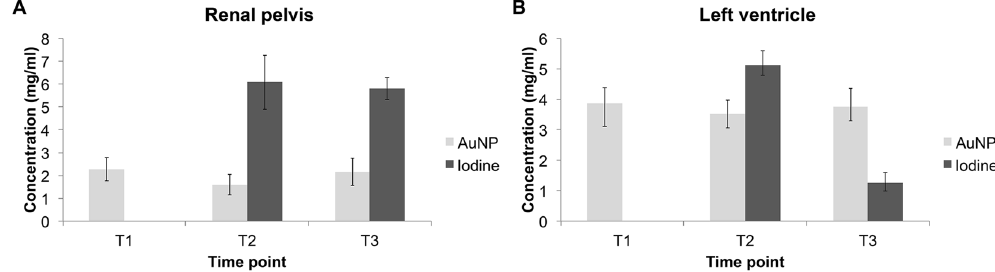
Figure 7. Concentrations of contrast agents in ( A ) the blood compartment and ( B ) the renal pelvis.